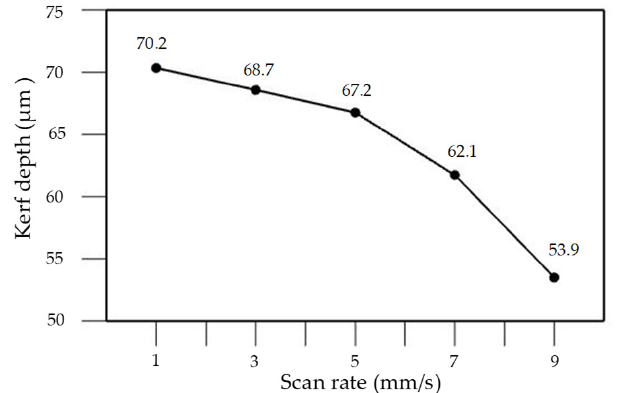
Figure 7. Relationship between scan rate and kerf depth (laser processing parameters are average power of 25.5 W, pulse width of 200 ns, and repetition rate of 170 kHz).